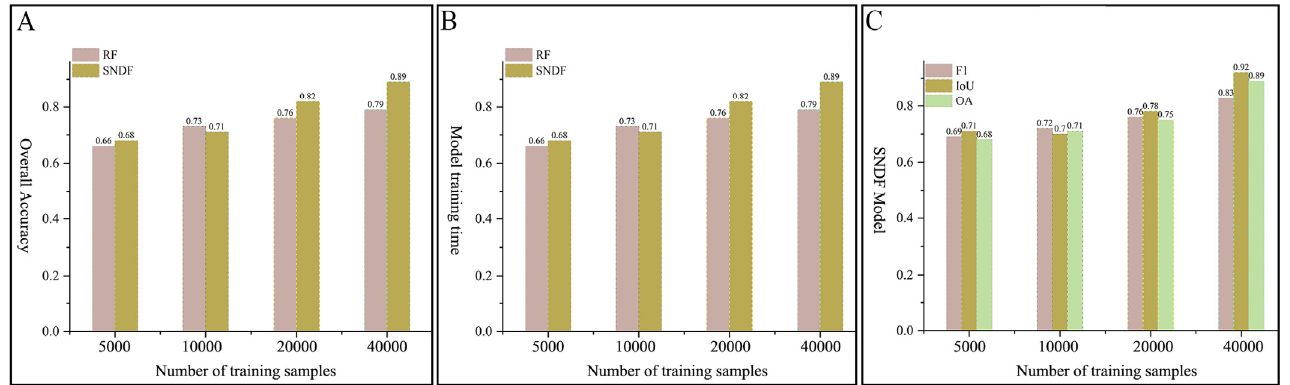
Figure 8. The influence of sample size on model accuracy and efficiency. ( A ) The final classification accuracy OA of the SNDF model and RF classifier; ( B ) the performance of SNDF and RF in training time; ( C ) the performance of SNDF model in F1, IoU and OA.